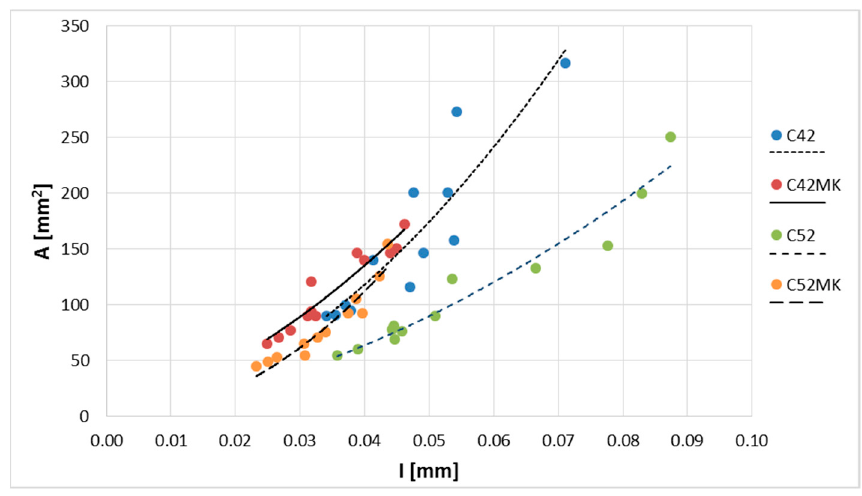
Figure 5. Cluster average area ( A ) as a function of the crack average width ( I ). Table 4. Equations of curves describing the A statistics ( R 2 , S e , W ) and the correlations coefficients ( ρ